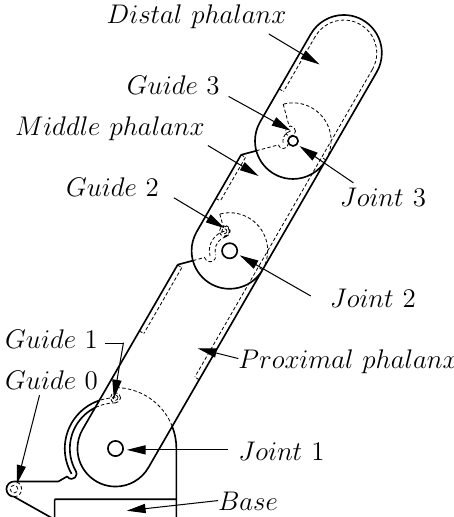
Figure 1. Design of the fingers proposed in Gosselin et al. (2008), which includes guiding rods.